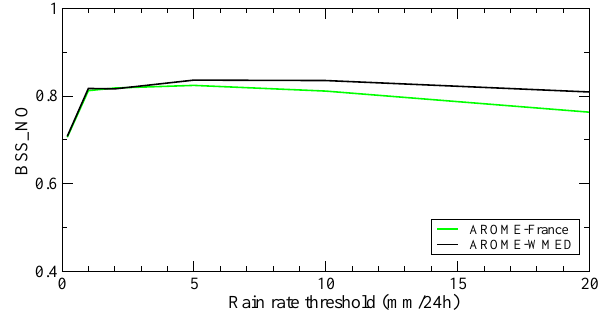
Figure 12. Brier skill score computed in a neighbouring distance of 54km for AROME-France (green) and AROME-WMED (black) computed with rain gauge data from France as a function of 6–30h rain rate threshold during the SOP1 period from 05 September to 05 November 2012. In this case, there is no significant difference.